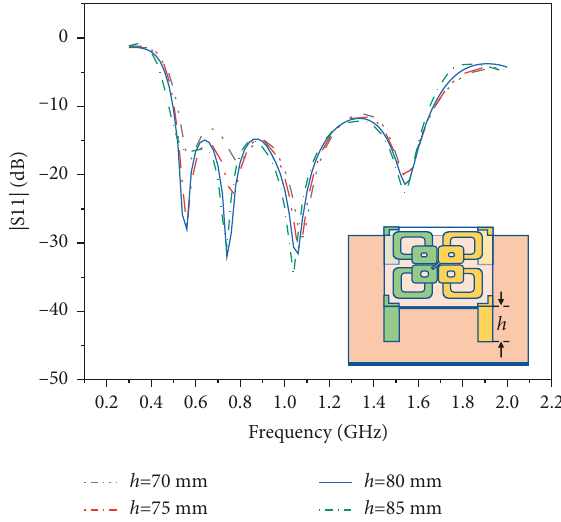
Figure 5: Effect of the distance (h) between the substrate and the ground on